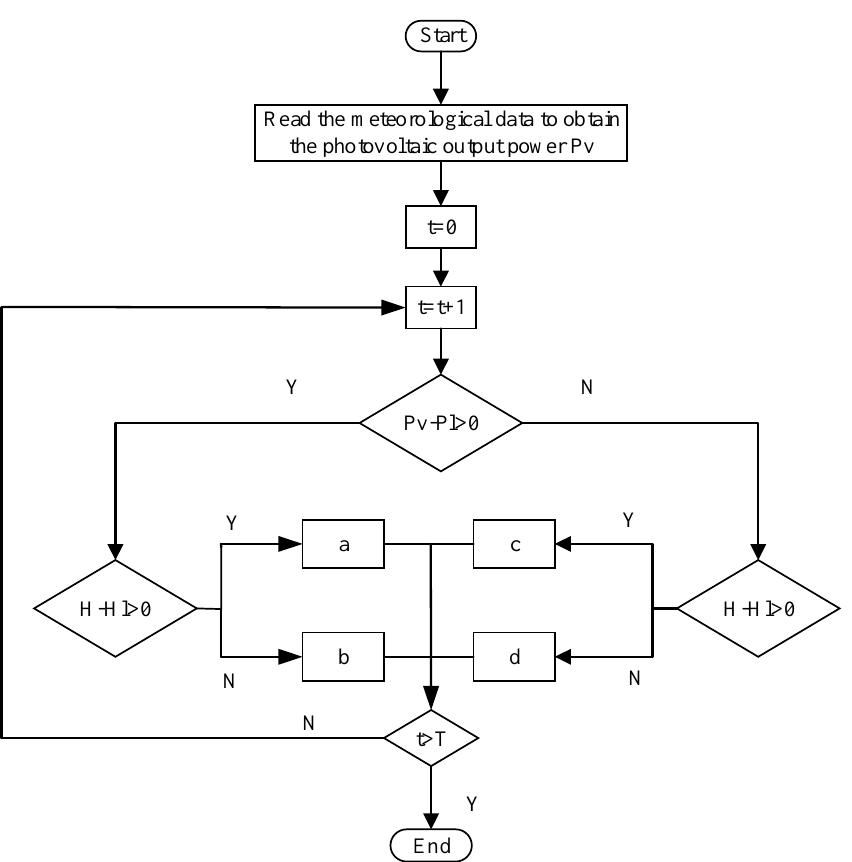
Figure 2. Energy flow strategy of the integrated charging station.